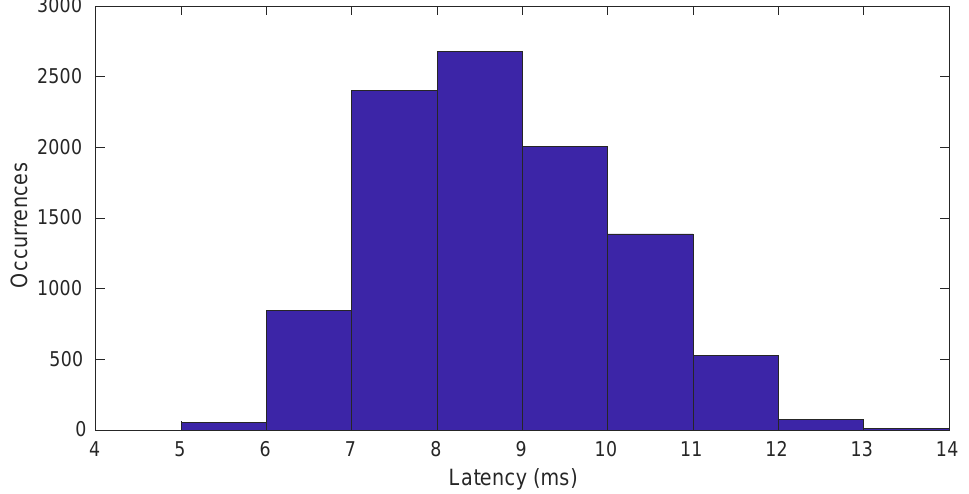
Figure 11. Histogram of the measured latency of the EMG signal path, with the output data rate set to 800 Hz, tested using 10,000 occurrences. The bluetooth connection interval was set to the minimum allowed by the specifications, i.e., 7.5